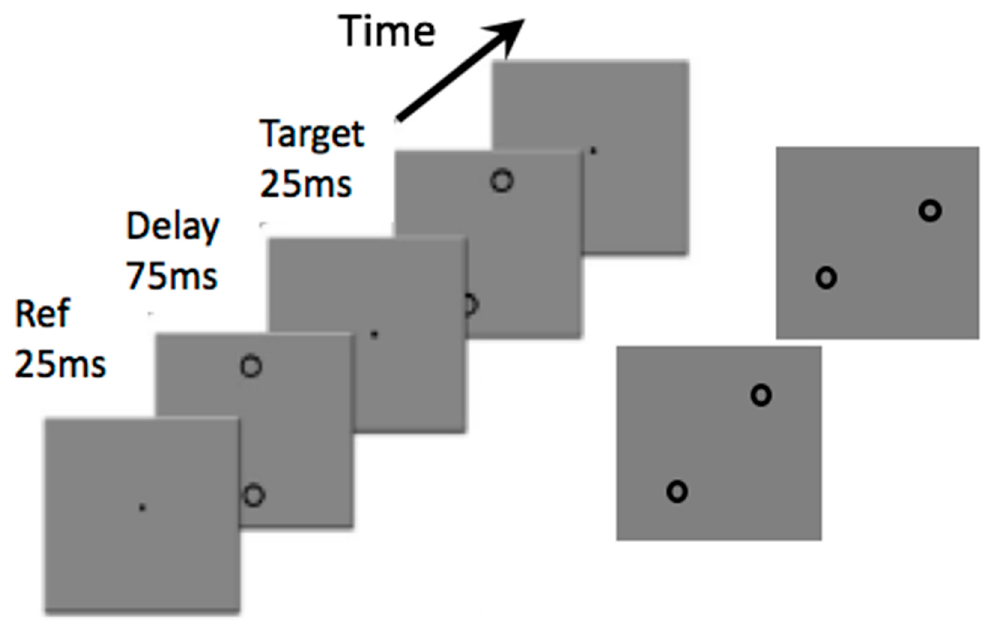
Figure 4. An example of the displays used to assess the oblique effect using virtual lines. As in Figure 3, in one condition the reference grating (“Ref”) is vertical and the test grating is oriented slightly clockwise or counter-clockwise to vertical. Thresholds for reliable discrimination can be determined. As in Figure 3, in the second condition, the reference is oriented at 45 degrees from vertical and orientation thresholds are again determined. Adapted from Tibber et al. [24].